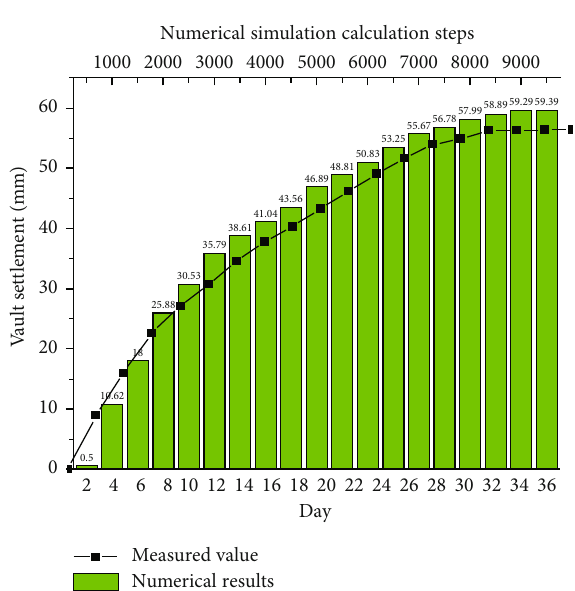
Figure 4: Comparison between numerical simulation and measured settlement of tunnel vault.